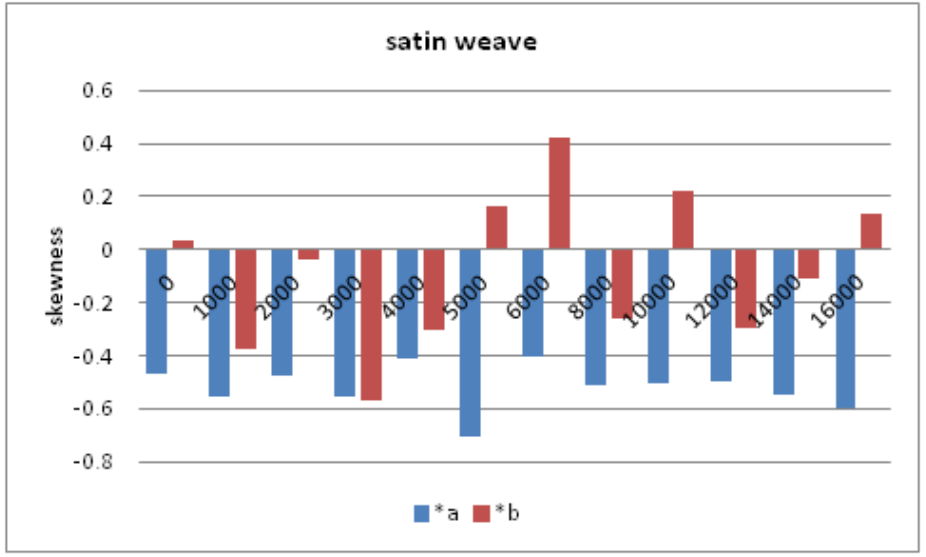
Figure 9. Skewness graph—Fabric